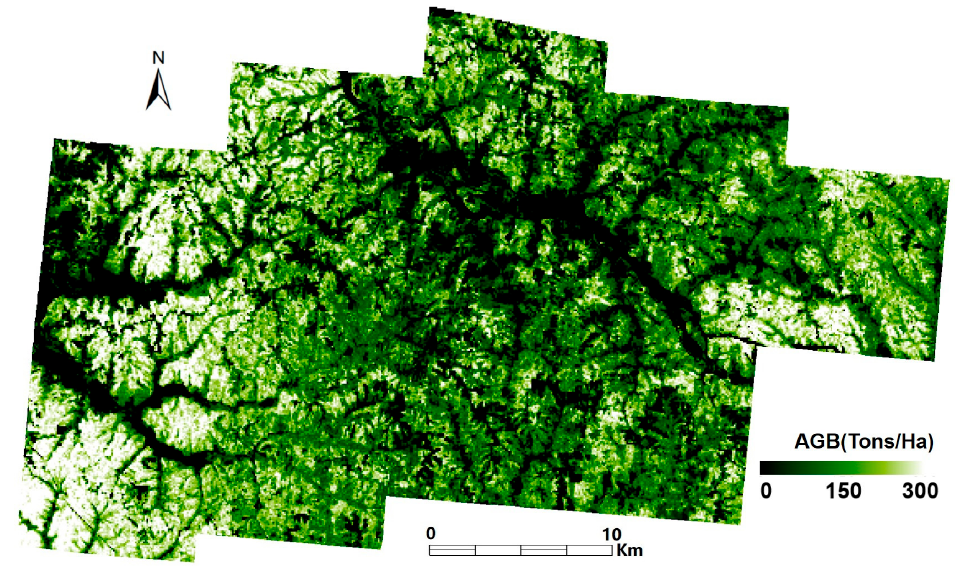
Figure 5. Above ground biomass estimated from seasonal NDVI time-series by an artificial neural network model.